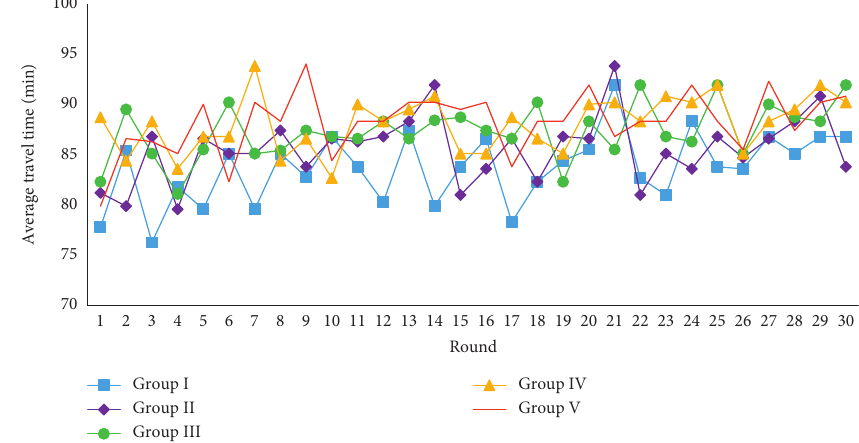
Figure 6: Average travel time distribution of the subjects in each round. Table 8: Mean and standard deviation of travel time in each group of experiments.